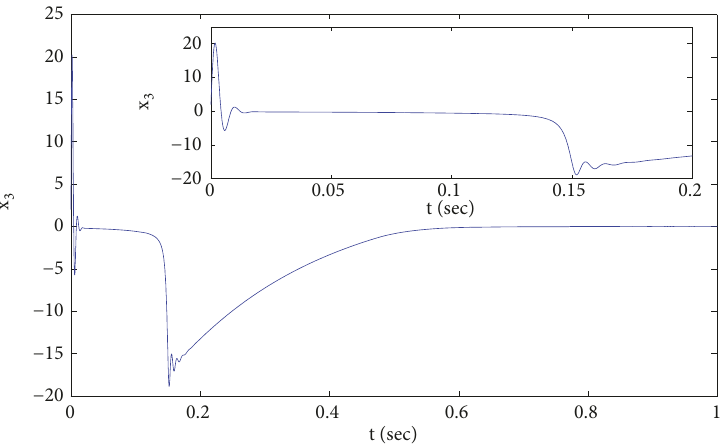
Figure 4: The time response of state 𝑥 3 of system (36) with controller (37).